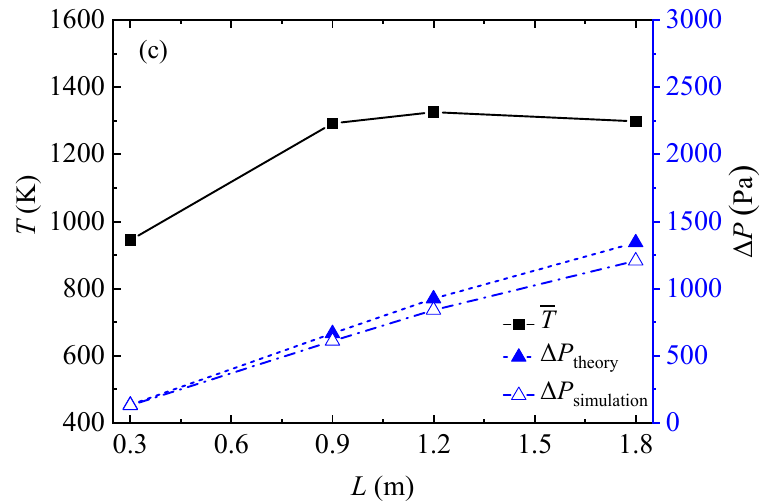
Figure 6. Mean gas temperatures and pressure losses obtained by theory and simulation for all cases: ( a ) various inlet methane volume fractions, ( b ) various gas velocities, and ( c ) various conduit lengths.